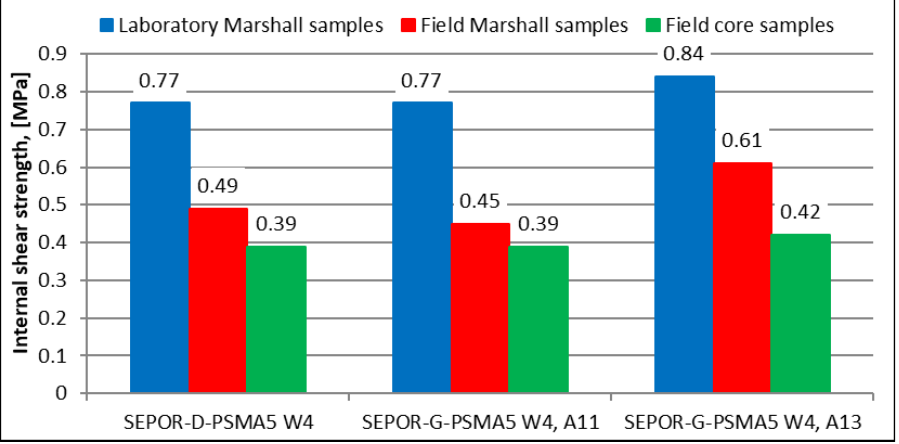
Figure 24. SEPOR-PSMA5 W4 laboratory test results: laboratory and field inlayer shear strength comparison.